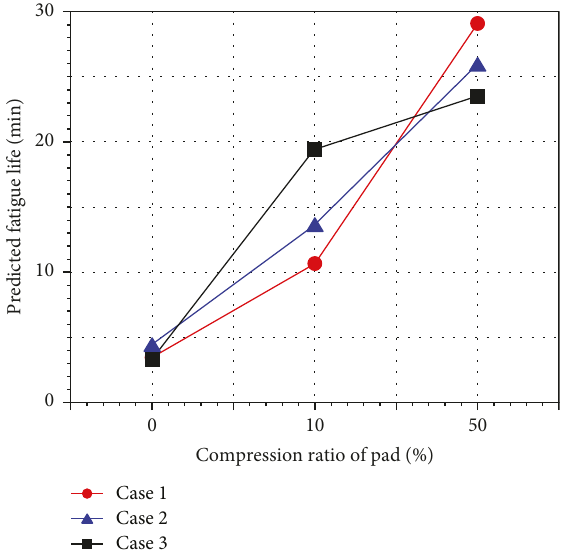
Figure 14: 1st eigenfrequencies of PCB for the compression ratio of the thermal gap pad in each case.